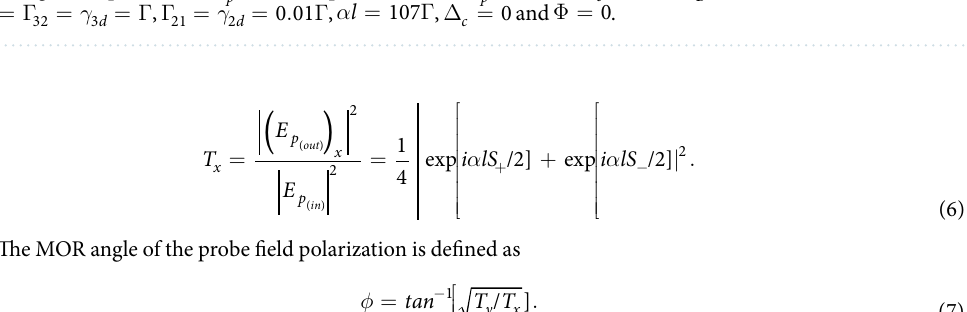
Figure 2. The imaginary ( a ) and real ( b ) parts of + S (dotted) and − S (dashed) and their difference (solid) versus detuning of the probe field Δ . The used parameters are Ω = . Γ 0 01 p